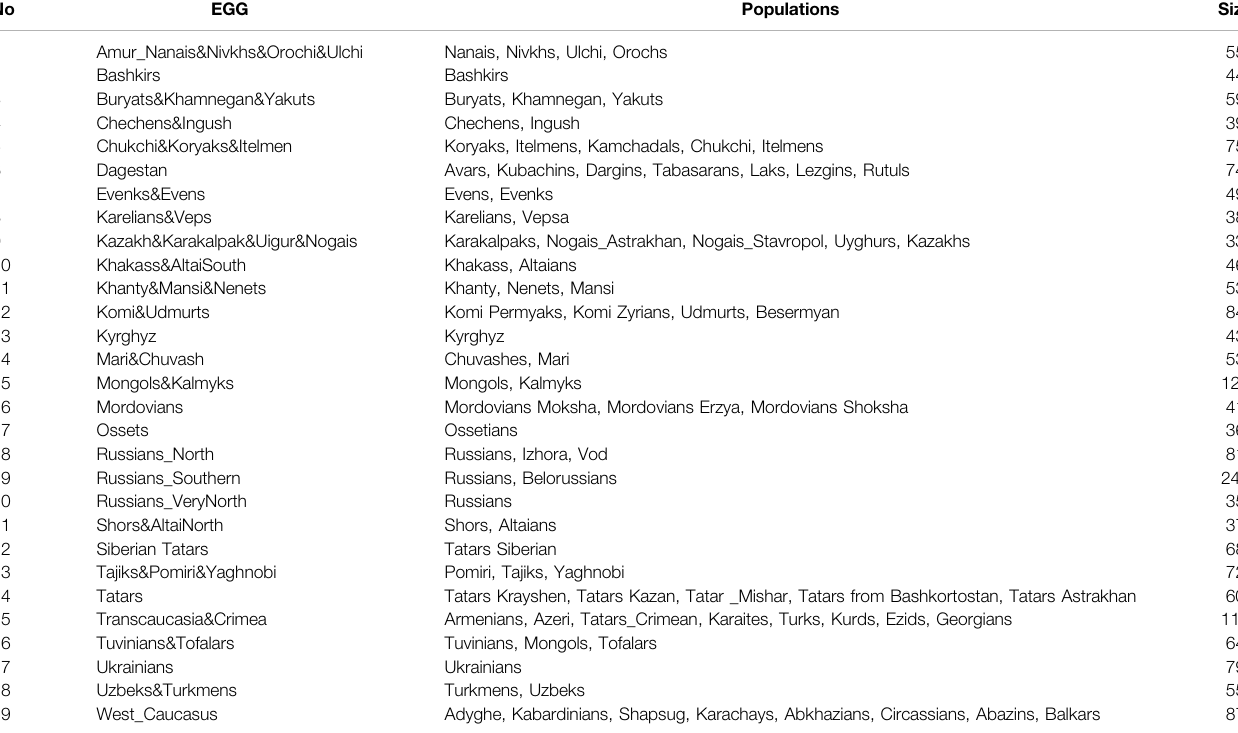
score. The F1 plot for different numbers of SNPs chosen for ancestry prediction is shown in Supplementary Figure S2